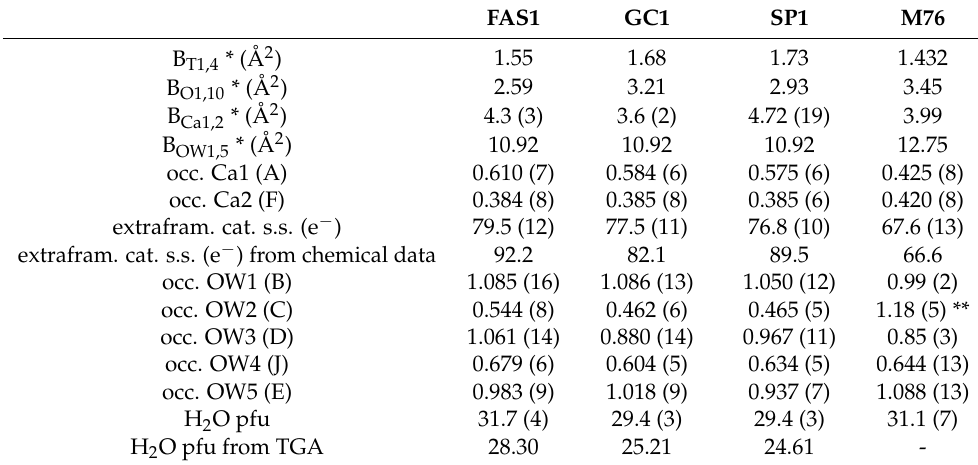
Table 7. Average isotropic displacement parameters (B iso ) and extra-framework cation and H 2 O molecule site population. Isotropic displacement parameters of H 2 O molecule sites were kept